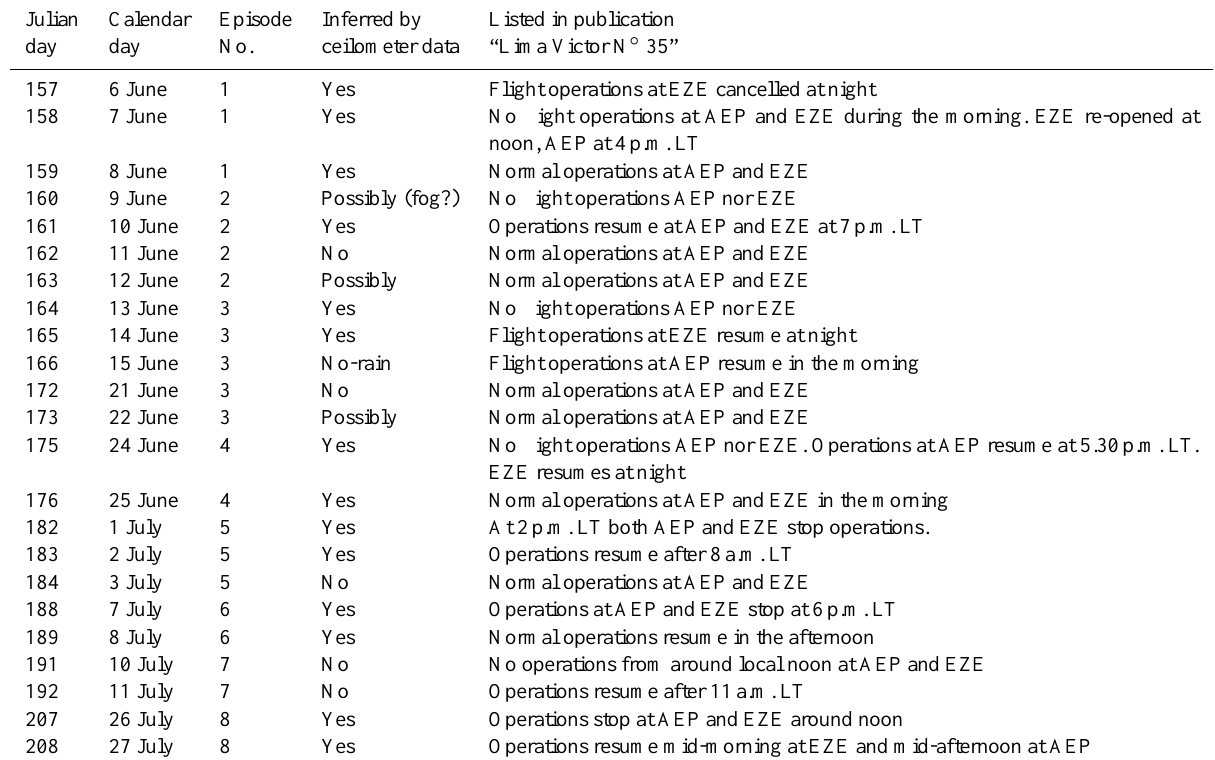
Table 1. List of all the eruptive episodes that led to shut downs of airport operations at Aeroparque (AEP) and Ezeiza (EZE) airports during the months of June and July